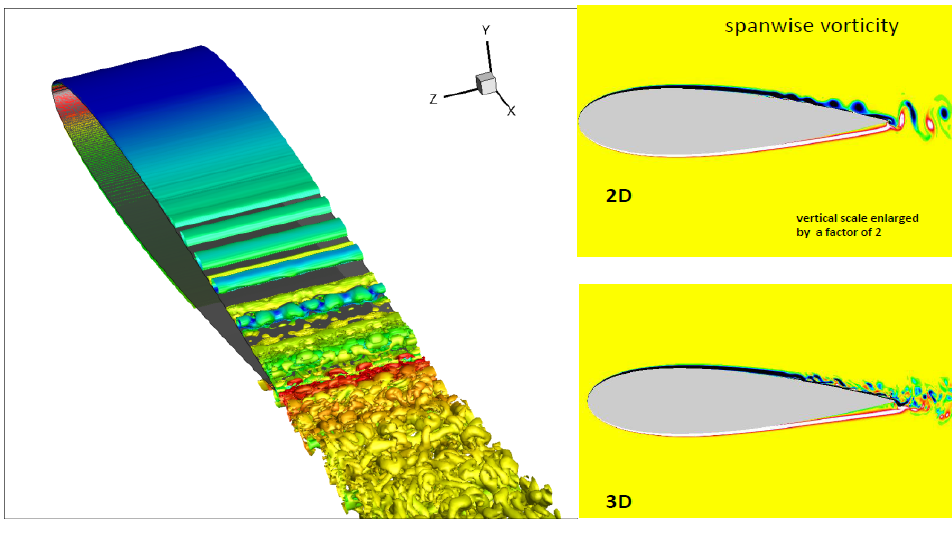
Figure 16. Time snapshots of BL vorticity dynamics from 2D and 3D ILES simulations. NACA- 0012 at 2° AoA, U = 25 m/s. (Adapted from [41]).